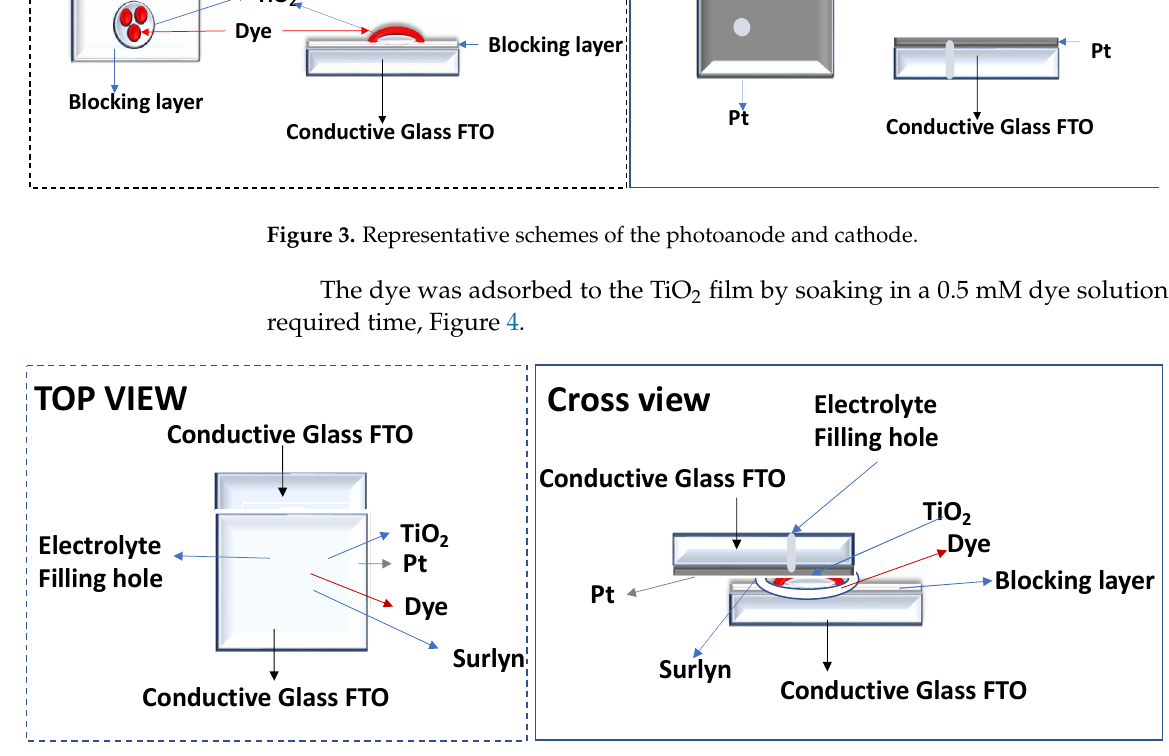
Figure 4. Schematic representation of DSSC assembly.